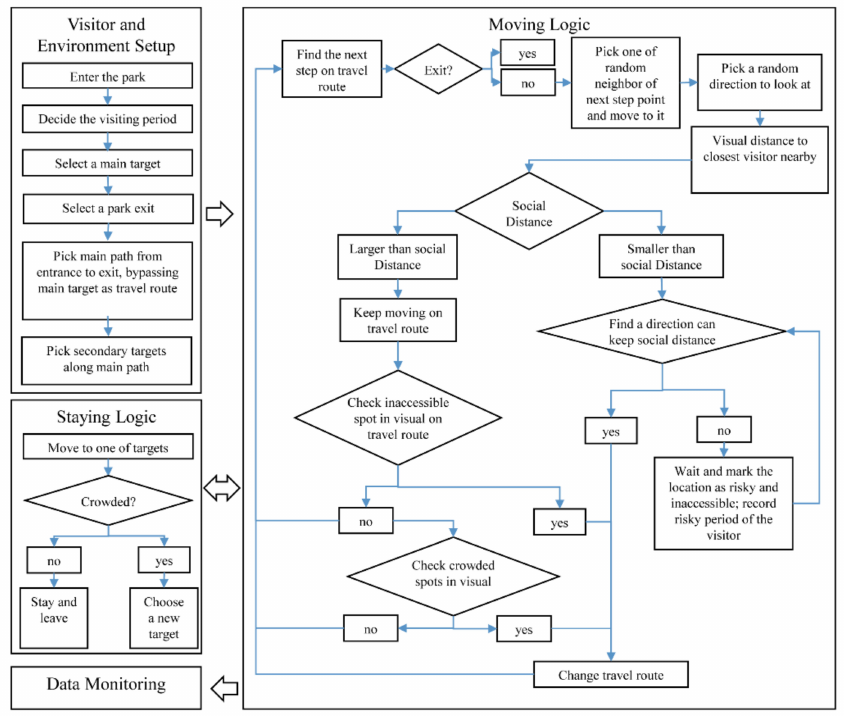
Figure A3. The diagram of moving and staying logic. Copyright 2020 © Author, all rights reserved, used by